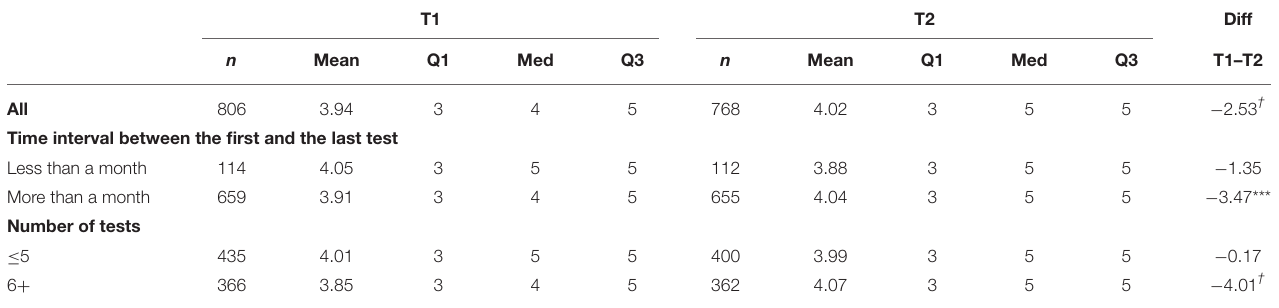
TABLE 4 | Perception of doubts about the accuracy of the COVID-19 test results–the first test and the last test in the classification of time between tests and the number of tests.